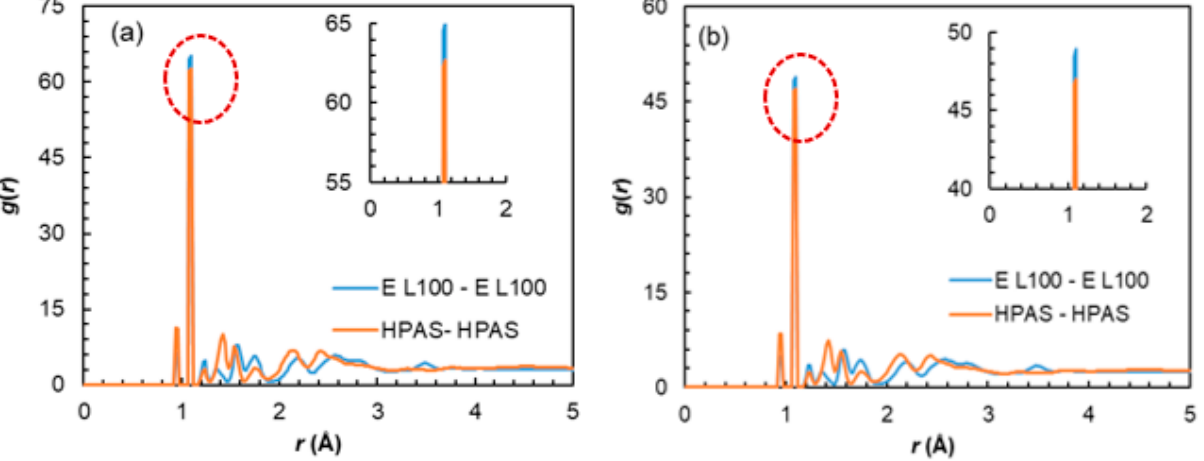
Figure 5. Radial distribution functions, g ( r ) of Eudragit L100 around Eudragit L100 and HPMC(AS) around HPMC(AS) in a mixture of these excipients with ( a ) DMF and ( b ) OPZ. The E L100 and HPAS in the figure legend indicate Eudragit L100 and HPMC(AS), respectively. The insets provide a zoomed-in view of the red circled portion.